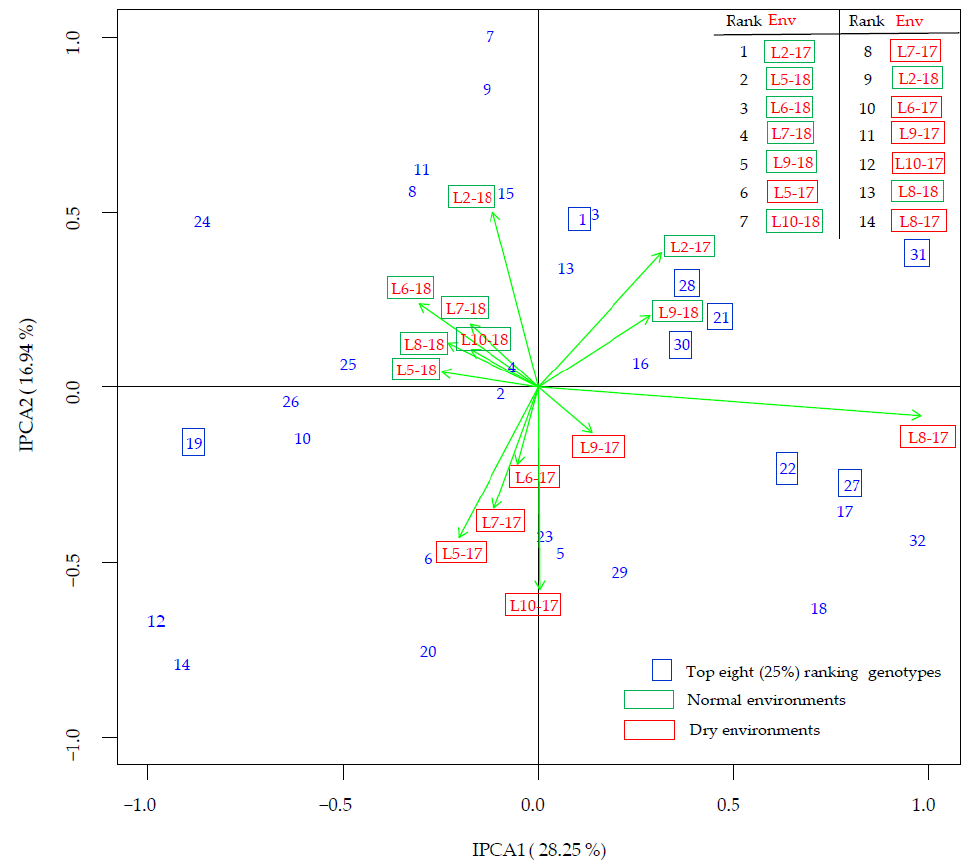
Figure 2. AMMI 2 biplot of 32 soybean genotypes evaluated in 14 environments (combination of seven locations with two cultivation years) for protein content.